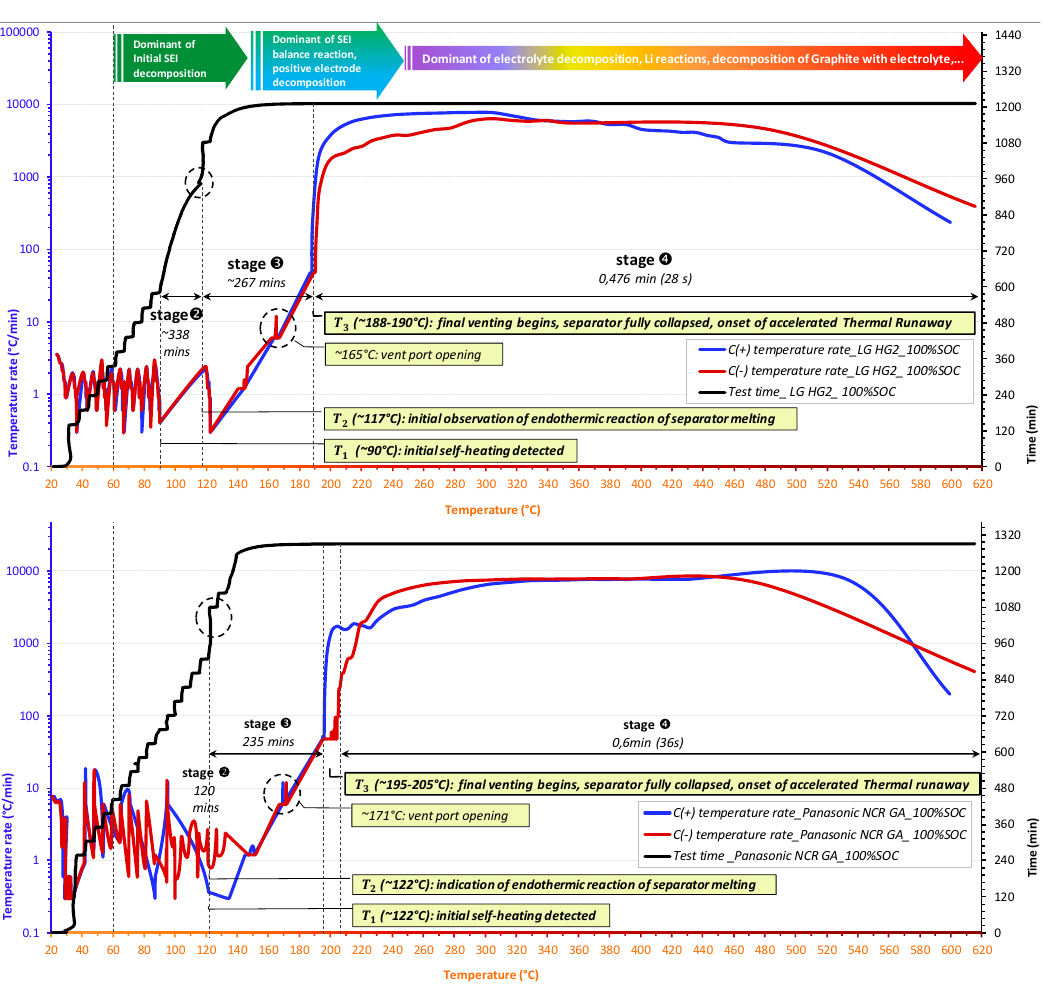
Figure 9. Temperature rates and test time versus temperature during the thermal runaway of the LG HG2 ( top ) and Panasonic NCR GA ( bottom ) pristine cells at 100% SOC.